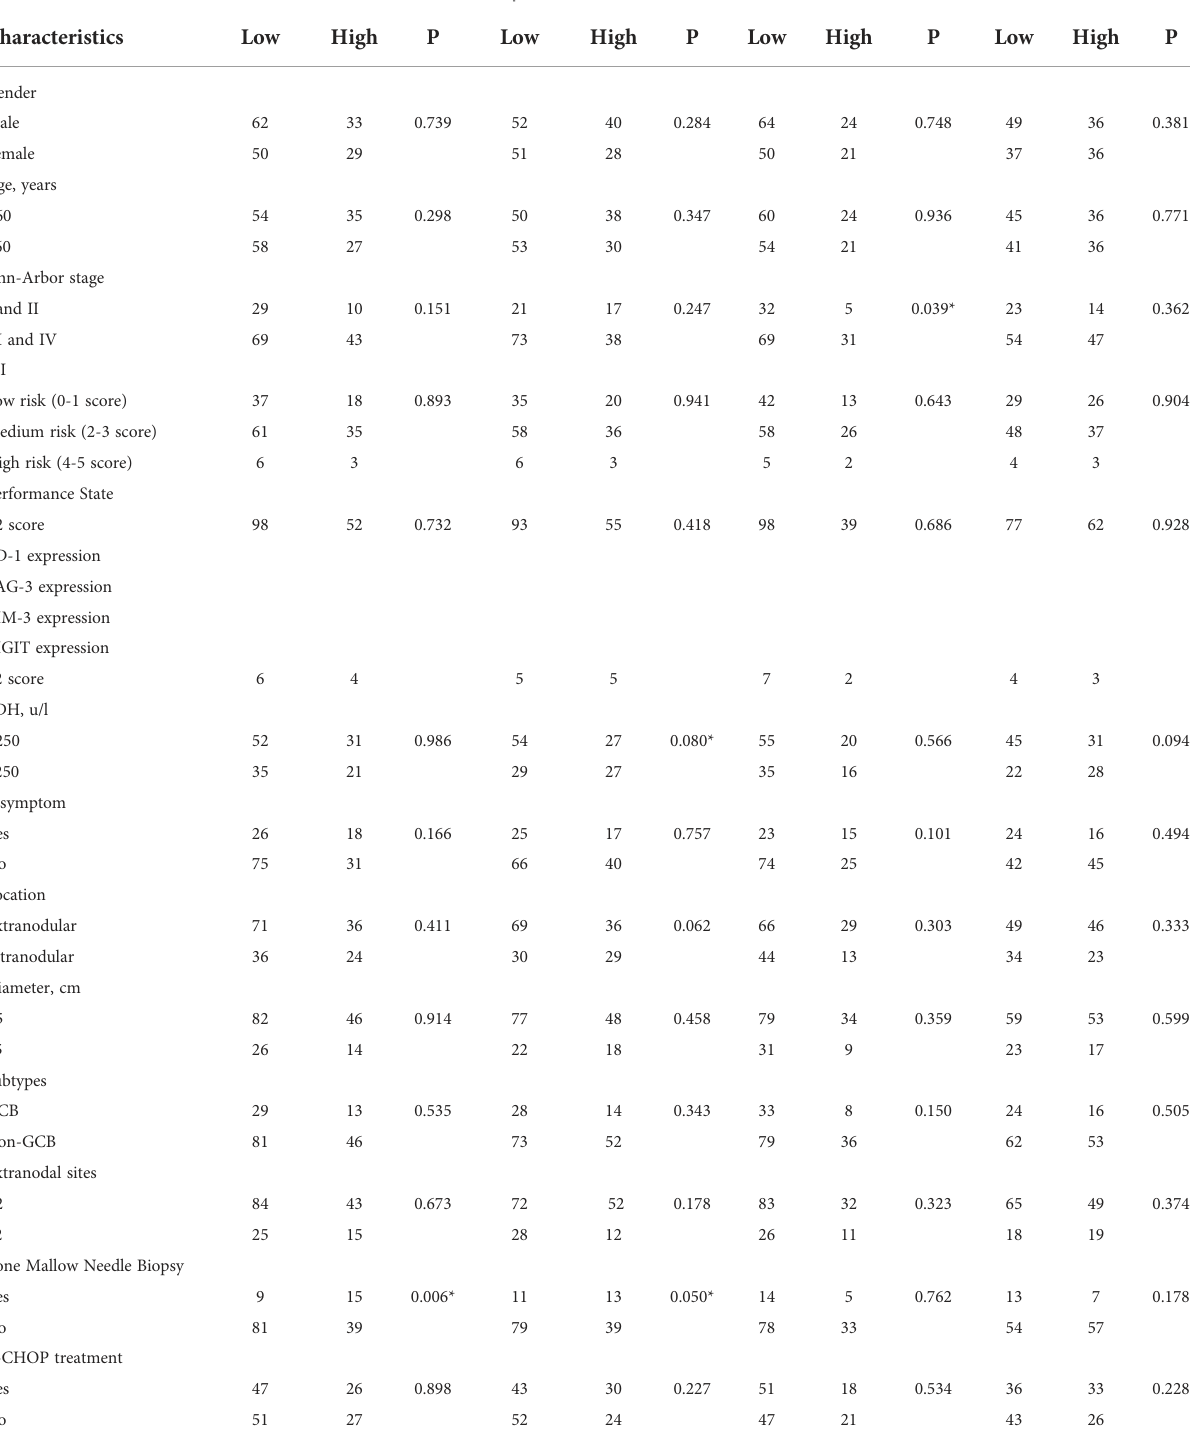
TABLE 1 Clinical relevance of PD-1, LAG-3 , TIM-3 and TIGIT expressions on TILs.